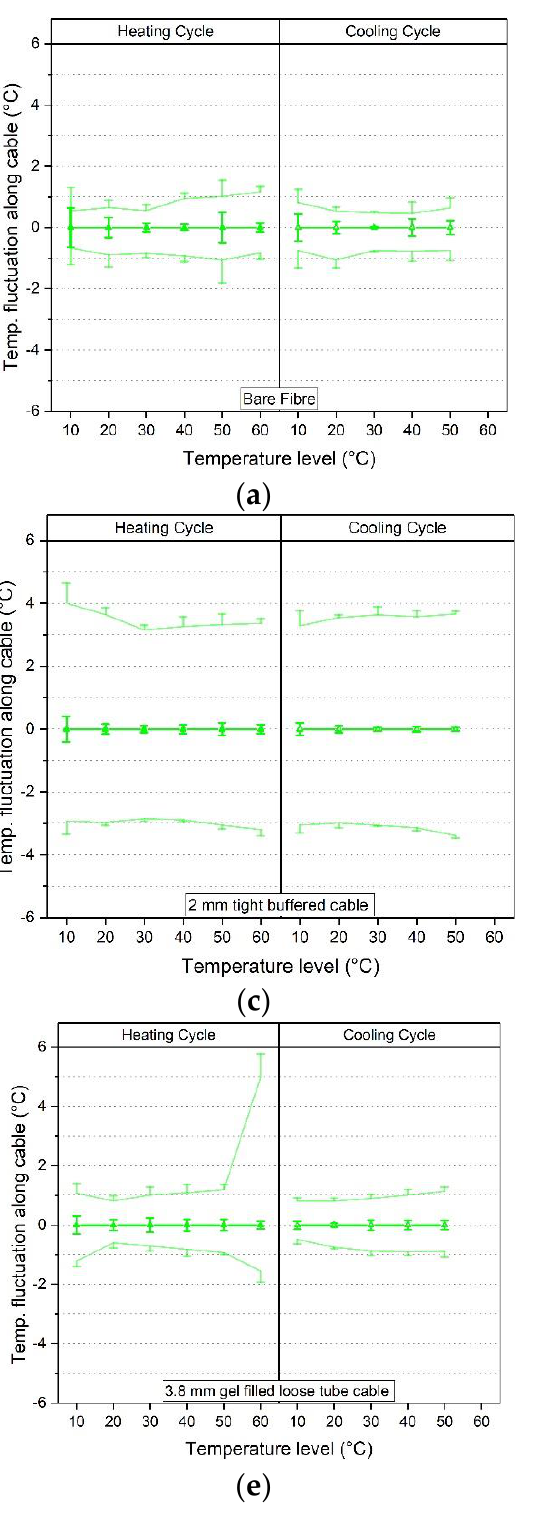
humidity (left column) are separated from the decreasing humidity cycle (right column). The results were again shown relative to a zero baseline (taken as the mean value of the frequencies at the three times considered) with the zero line mean and standard deviation, SD, shown as thick solid lines. The maximum and minimum fluctuation along the cable are shown as dashed lines. So to obtain the actual humidity magnitude, the humidity shown along the x-axis needs to be added to the mean, minimum and maximum values. The standard deviation of the zero line demonstrates the humidity drift with time, as observed in Figure 13. The tight buffered cables show a maximum peak humidity reading in the range of between 7.1 and 41.0% rel. H. The 0.9 mm shows the lowest maximum,